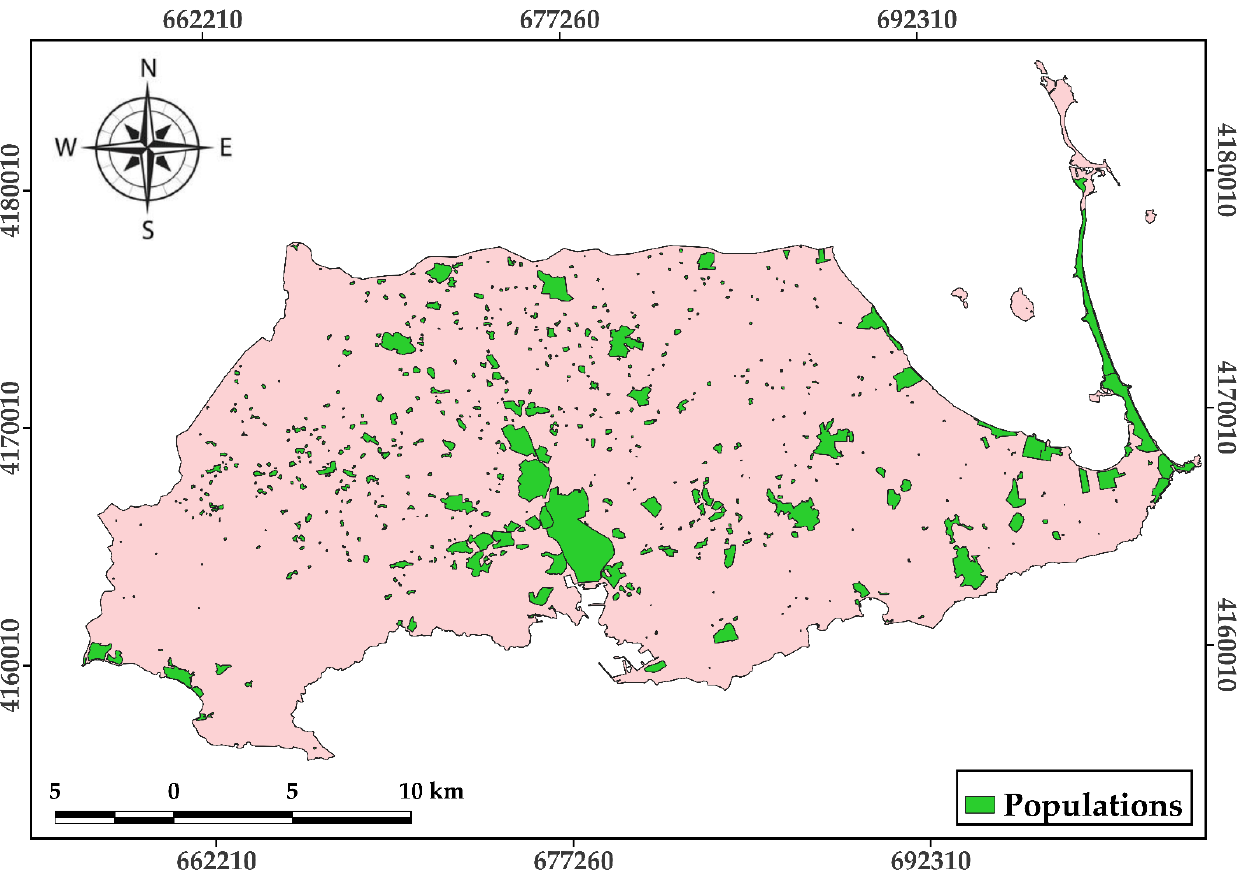
Figure 1. Population centers in the Municipality of Cartagena (own elaboration).